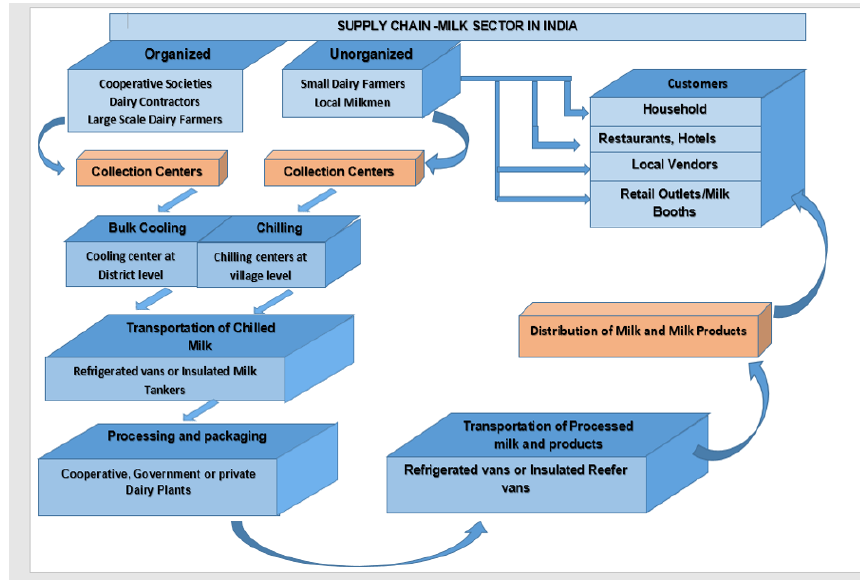
Figure 1. Supply chain network of milk sector in